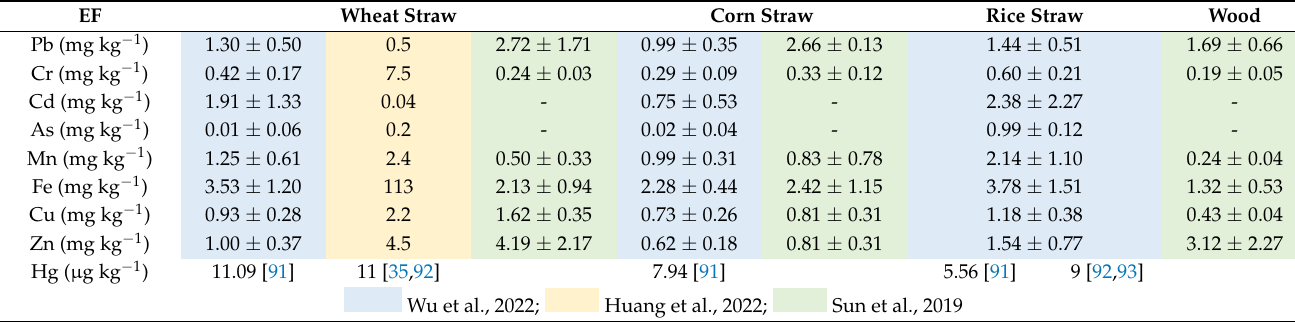
Table 2. Emission factors of heavy metals [21,37,90]. EF Wheat Straw Corn Straw Rice Straw